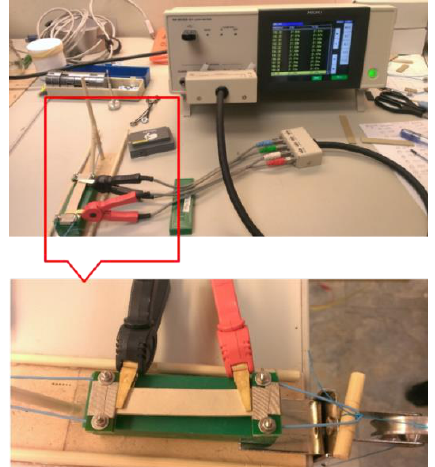
Figure 1. Pictures of the tensile testing apparatus using a pulley along with calibration weights. The impedance was measured by a HIOKI LCR Meter IM3533-01 (HIOKI, Nagano, Japan). Each sample was cut into the pieces 1 cm × 7 cm × 0.1 cm.